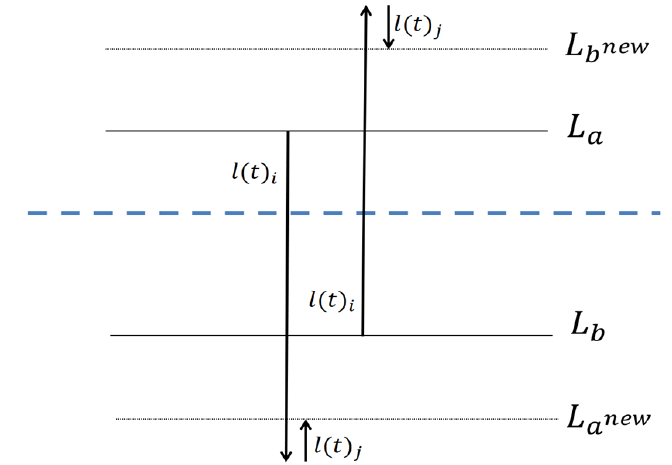
Figure 5. The loads of each of the two clusters at the end of all